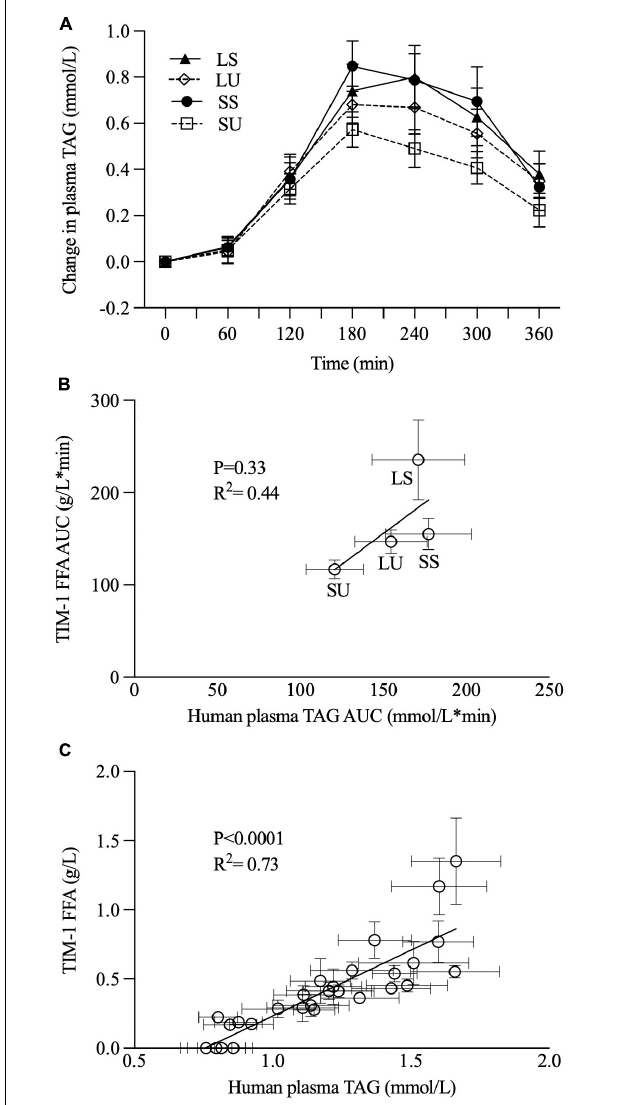
FIGURE 8 | Postprandial changes in plasma TAG concentration were observed when healthy men consumed 250 ml of SS, SU, LS, and LU (A) , as previously reported [Hamad et al., (29)] and correlation analyses between TIM-1 6-h bioaccessible FFA AUC (g/L*min, n ≥ 3) and human study 6-h plasma TAG AUC (mmol/L*min, n = 15) (B) and between TIM-1 bioaccessible FFA (g/L, n ≥ 3) and human study plasma TAG data over 6 h (C) . Error bars represent SEM. LS, liquid lipid-acid stable emulsifier; LU, liquid lipid-acid unstable emulsifier; SS, solid lipid-acid stable emulsifier; SU, solid lipid-acid unstable emulsifier; TAG, triacylglycerol; FFA, free fatty acid; AUC, area under the